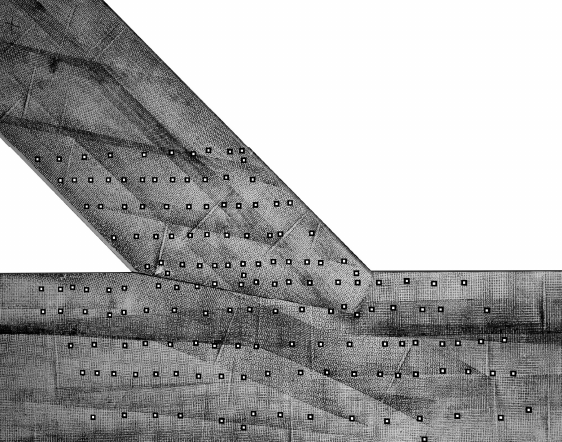
Figure 10. A total of 150 inspect points placed on the surface in the DIC post-processing to extract the displacements for the calibration of the numerical model.